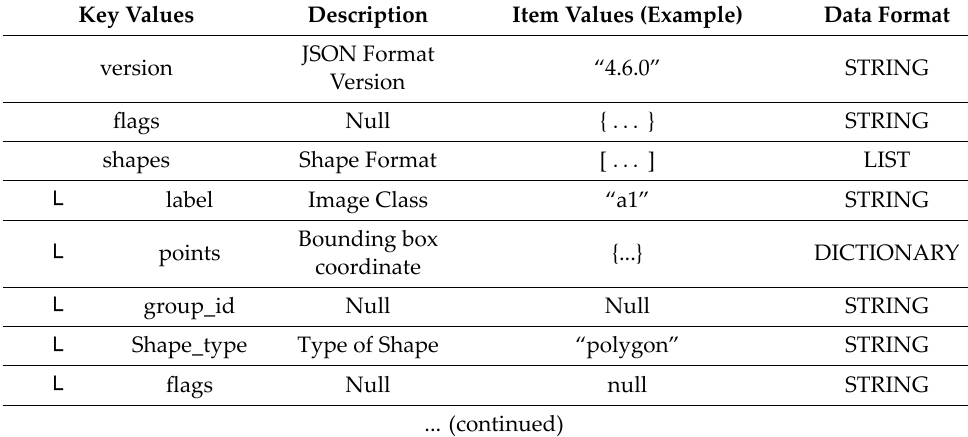
Table 3. COCO Format metadata for training. Table 2. JSON format metadata structure of labeled image.